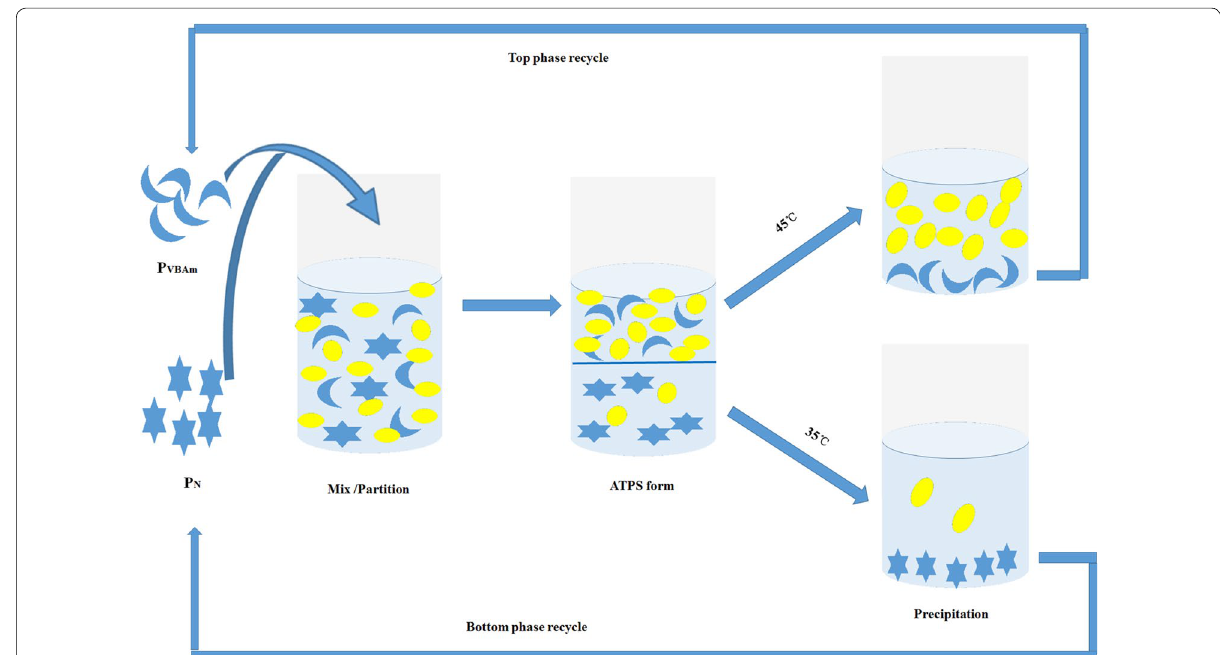
Fig. 7 Formation and recycling diagram of P VBAm / P N ATPS. The yellow circle is the symbol of the target biomolecule